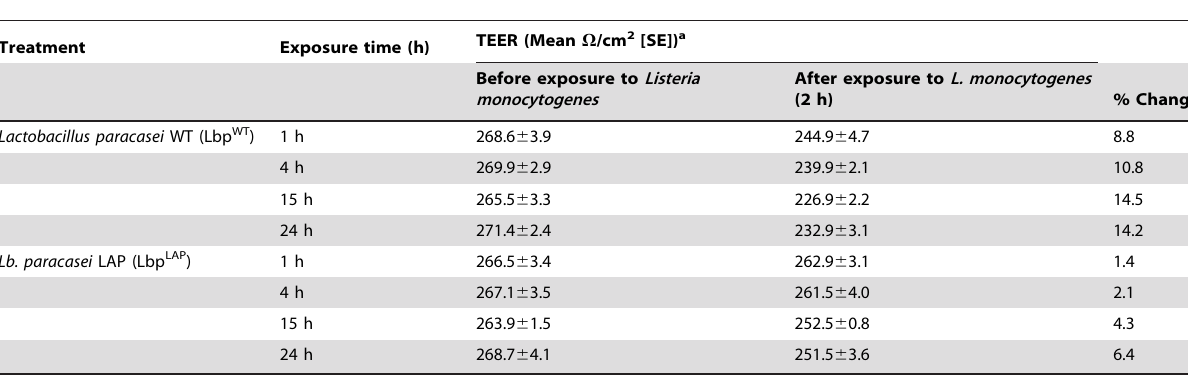
Table 3. Caco-2 cell permeability analysis using transepithelial electrical resistance (TEER).